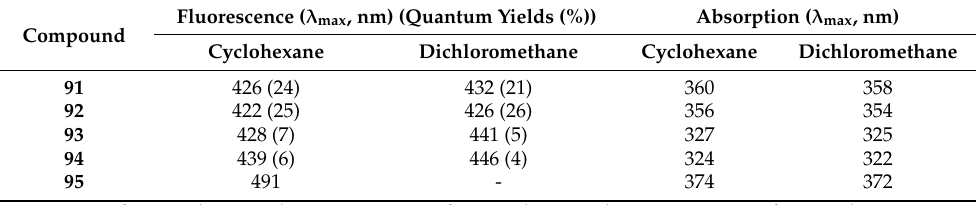
Table 16. λ max (nm) of absorption spectra, λ max (nm) of emission spectra, and relative quantum yields (%) of compounds 91 – 95 .